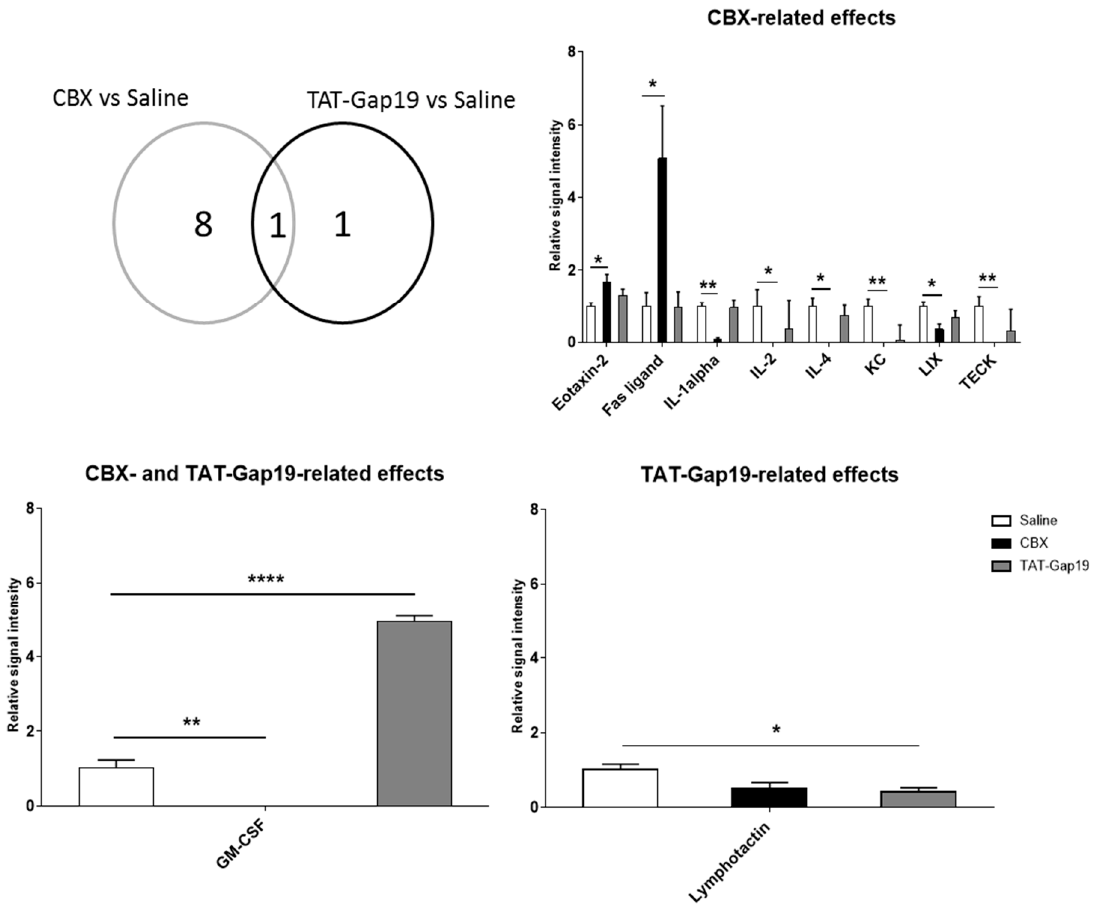
Figure 6. Effects of CBX and TAT-Gap19 on the inflammatory response after TAA-induced chronic hepatic injury in mice. Mice were administered TAA intraperitoneally for eight weeks. Initially, mice ( n = 4/group) were administered with 100 mg TAA/kg body weight, followed by 10% weekly increments to the utmost dose of approximately 200 mg TAA/kg body weight. Thereafter, an osmotic pump was implanted in the peritoneal cavity, which ensured the release of 1 mg TAT-Gap19 or CBX/kg body weight/day or saline for two weeks. After comparison between CBX versus saline with TAT-Gap19 versus saline groups, three clusters of inflammatory proteins were defined, namely (i) CBX-related effects; (ii) CBX- and TAT-Gap19-related effects; and (iii) TAT-Gap19-related effects. Data were analyzed by densitometric analysis. Then, background was subtracted, and results were normalized against the average of positive controls. Results were analyzed by 1-way ANOVA followed by post hoc Bonferroni correction. Data were expressed as means ± SEM (* p ≤ 0.05; ** p ≤ 0.01; **** p ≤ 0.0001). (GM-CSF, granulocyte-macrophage colony-stimulating factor; IL1 α /2/4, interleukin 1 α /2/4; KC, growth-regulated alpha protein; LIX, lipopolysaccharide-induced CXC